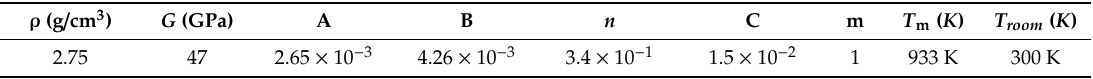
Table 9. Parameters of aluminum